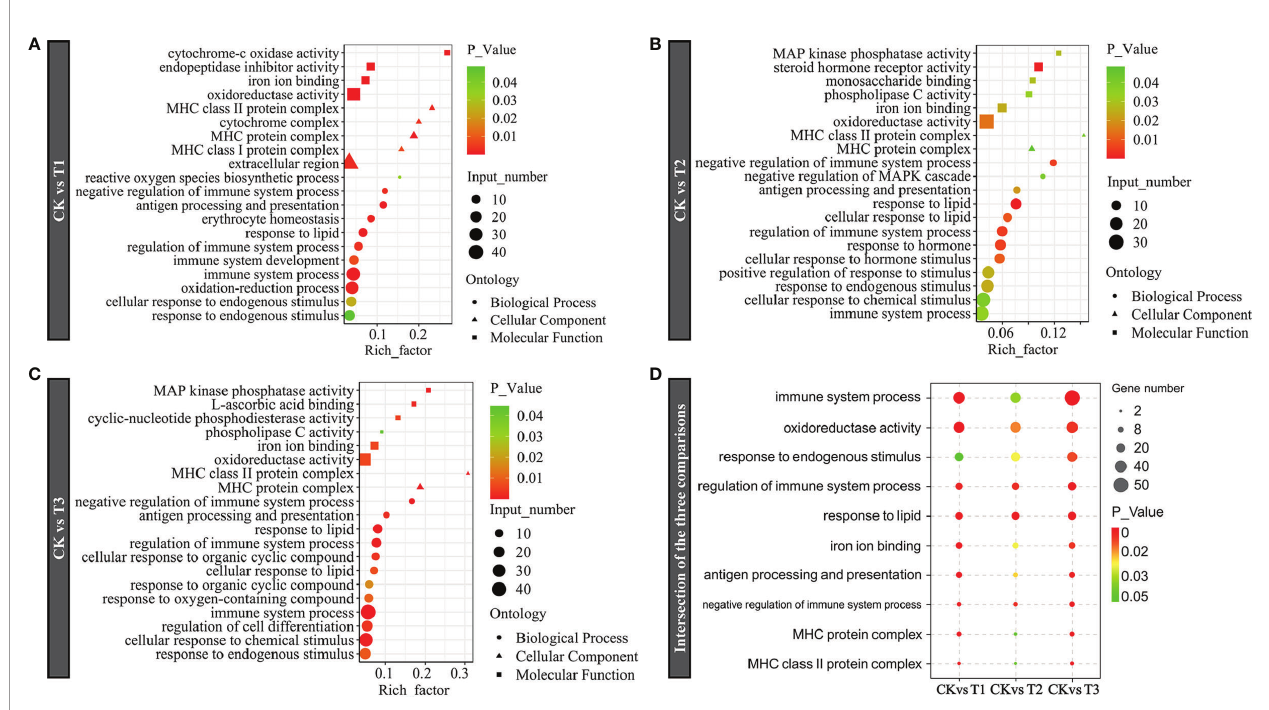
FIGURE 5 | Gene Ontology (GO) term enrichment of dramatically DEGs in (A) CK vs. T1, (B) CK vs. T2, and (C) CK vs. T3. (D) Intersection of the three comparisons. Bubble plots represent remarkably enriched GO terms within the DEGs. The y -axis designates GO terms, and the x -axis exhibits the rich factor. The P-value indicates the enrichment importance of the GO terms, with lower P-values suggesting higher intensity. CK: normoxia, T1: hypoxia, T2: semi- asphyxia, T3: